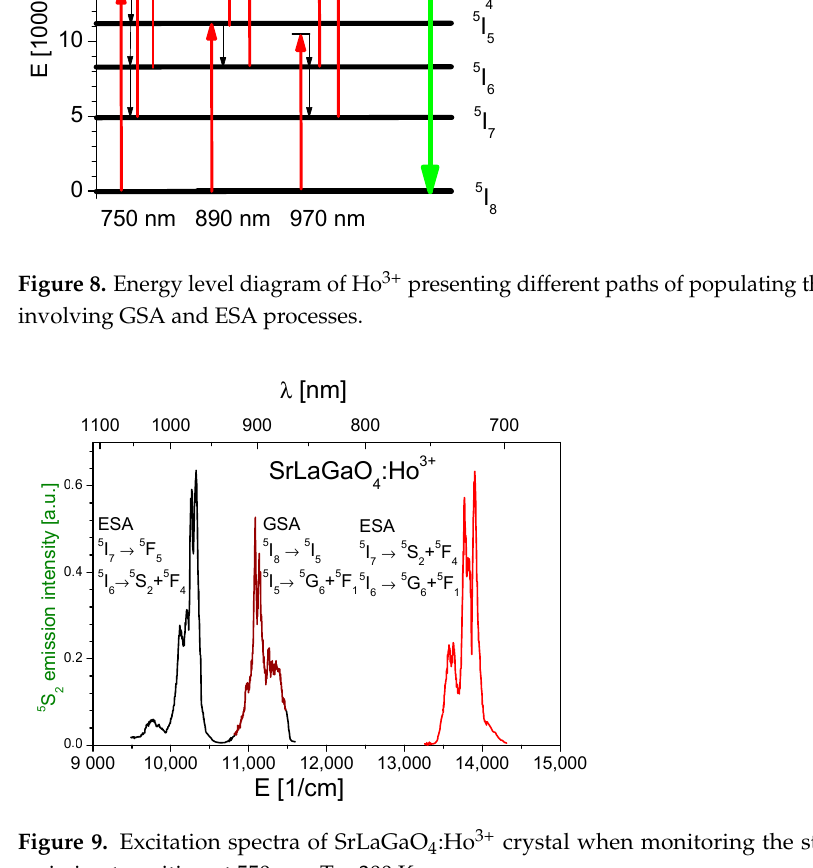
Figure 9. Excitation spectra of SrLaGaO 4 :Ho 3+ crystal when monitoring the strongest 5 S 2 → 5 I 8 emission transition at 550 nm, T = 300 K.